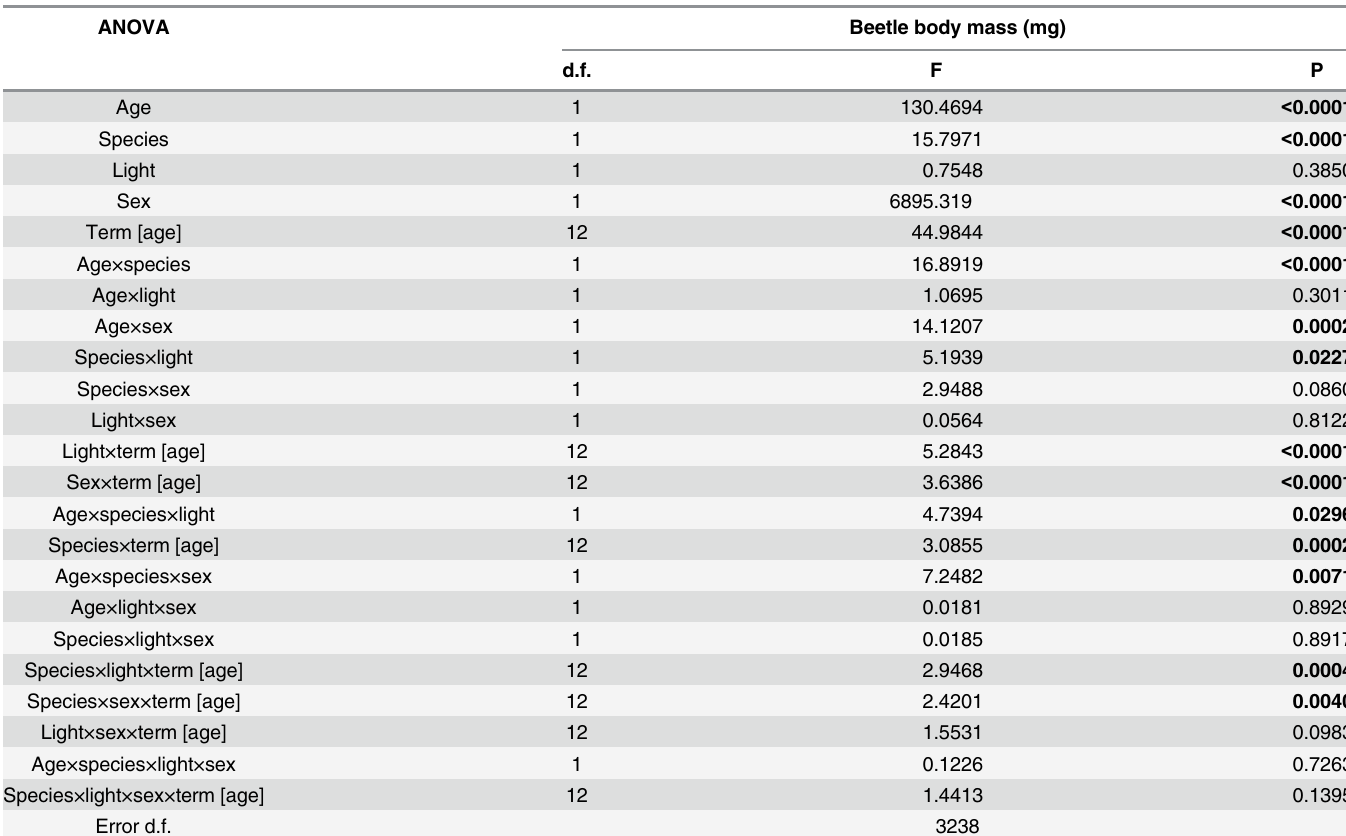
Table 1. Summary of ANOVA on the effects of time of occurrence (age: current-year vs 1-year-old), cherry species ( Prunus padus vs P . serotina ), light conditions (high light vs shade), sex (female vs male), term (length of the sampling period, see Materials and Methods) and their interactions on the body mass of adult Gonioctena quinquepunctata beetles. The factor “ term ” was nested in the factor “ age ” (term[age]). P values < 0.05 are in bold.